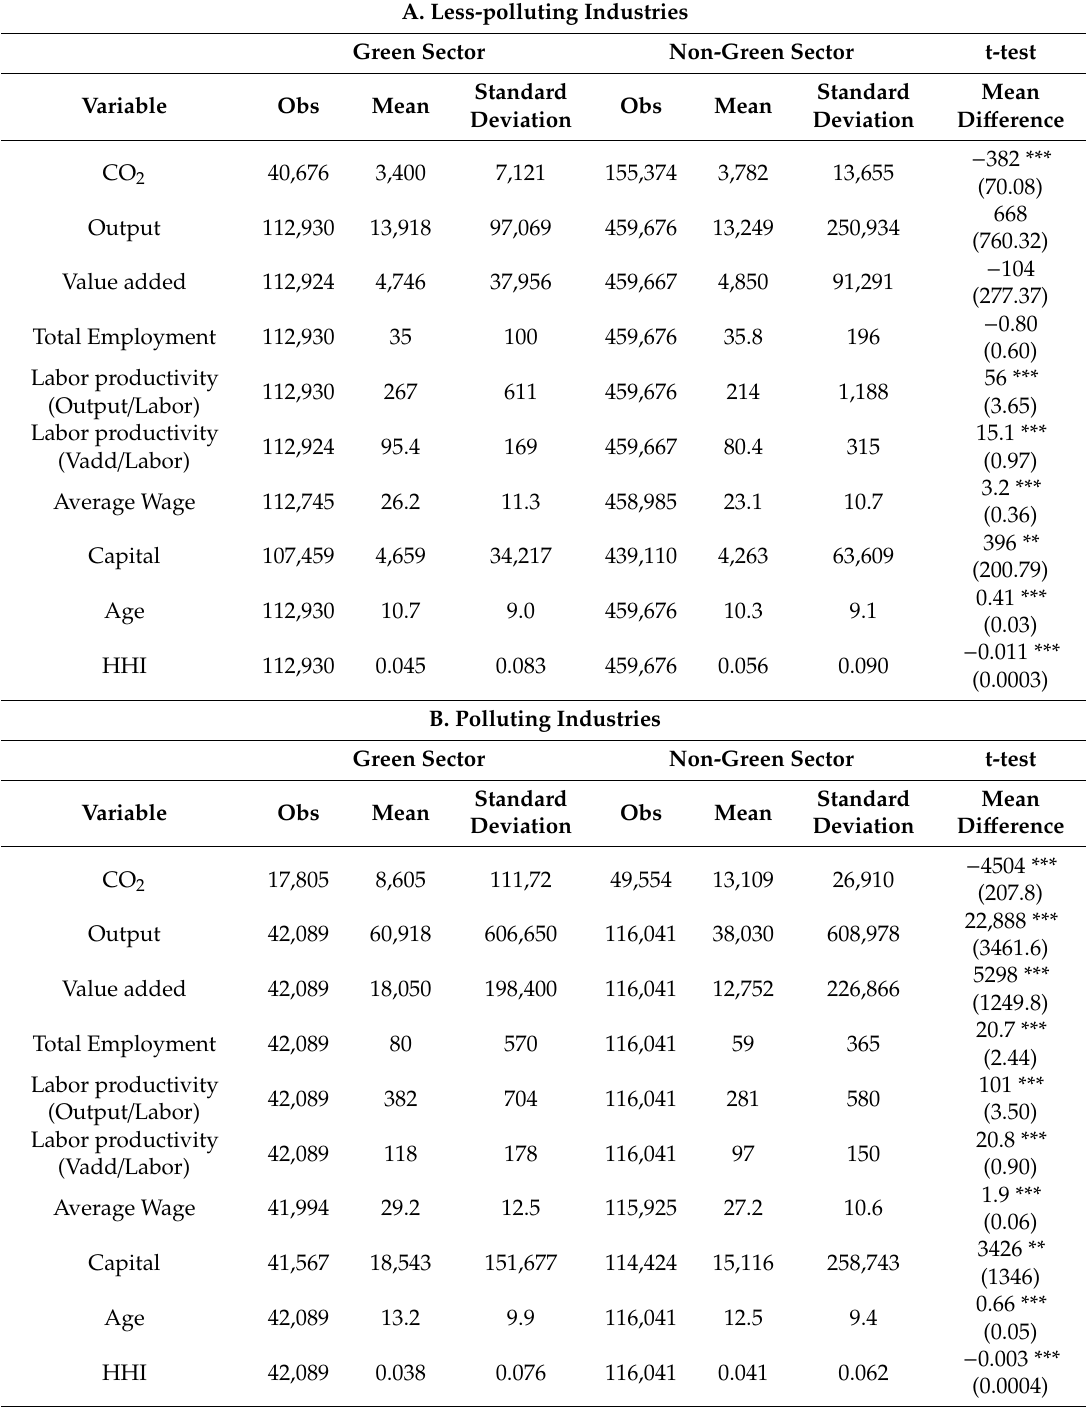
Table 1. Summary statistics of the data (by green sector and polluting